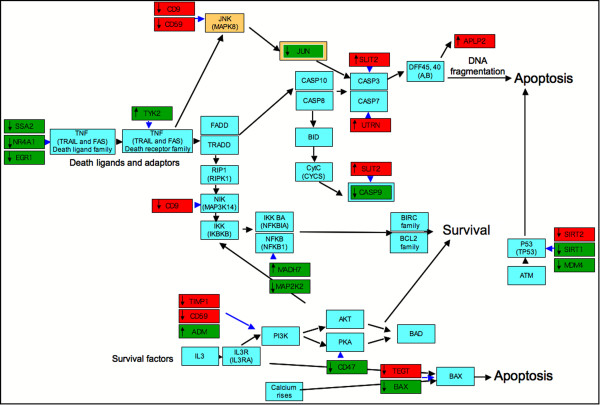
Summary of the effects of gene over-expression on the mRNA levels for genes associated with apoptotic pathways. Central pathway has been adapted from the KEGG apoptotic pathways (light blue) and BD Biosciences apoptotic pathway (light orange). A gene is shown on the pathway if present in at least one of the time points in at least three of the 4 individual treatments. Arrows within the gene mRNA boxes indicate genes with increased or decreased expression. Genes coloured red potentially increase apoptosis, genes coloured green potentially decrease apoptosis according to the literature (see Additional file 4 Table Two and Three and Additional file 5 Figures Three to Seven for Apoptosis Differentials List and more comprehensive pathways).